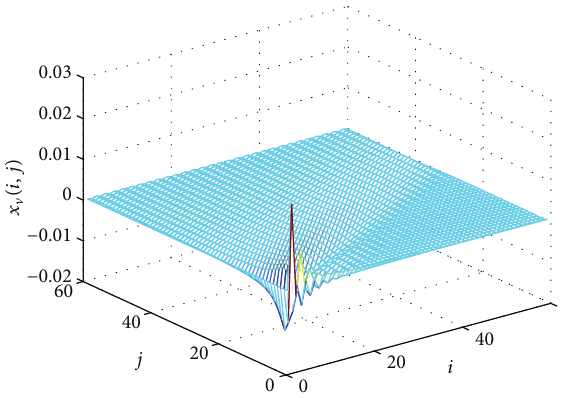
Figure 4: State response of 𝑥 V (𝑖,𝑗) for Example